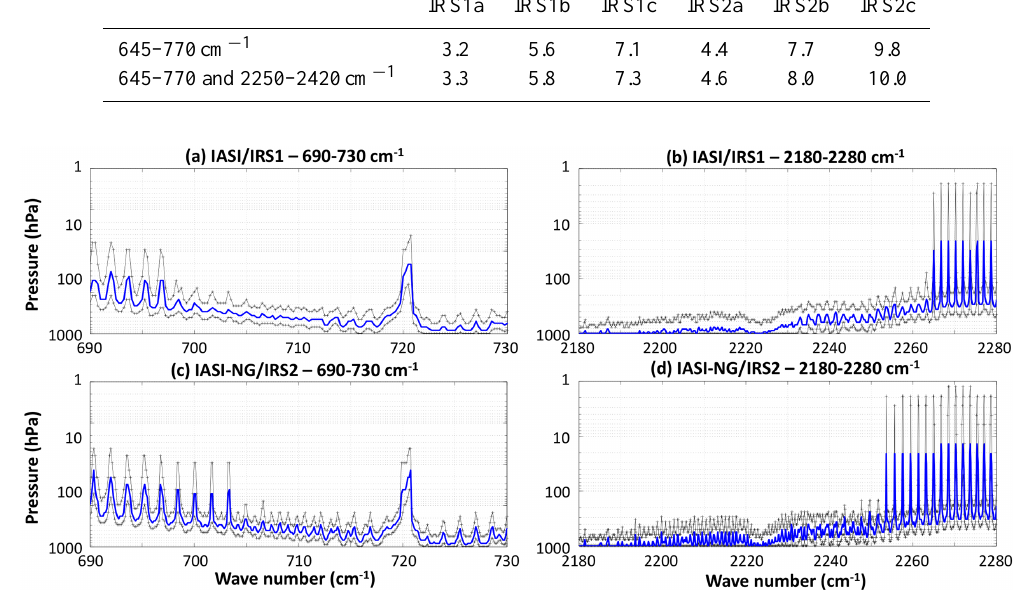
Figure 4. Pressure of the maximum (blue line) and of the half-height width (black) of the temperature Jacobians at the IASI spectral resolution in the 15µm (a) and 4.3µm (b) bands and at the IASI-NG spectral resolution in the 15µm (c) and 4.3µm (d) bands. The Jacobians have been computed by 4A and averaged over the whole tropical atmospheric situations of the TIGR database.